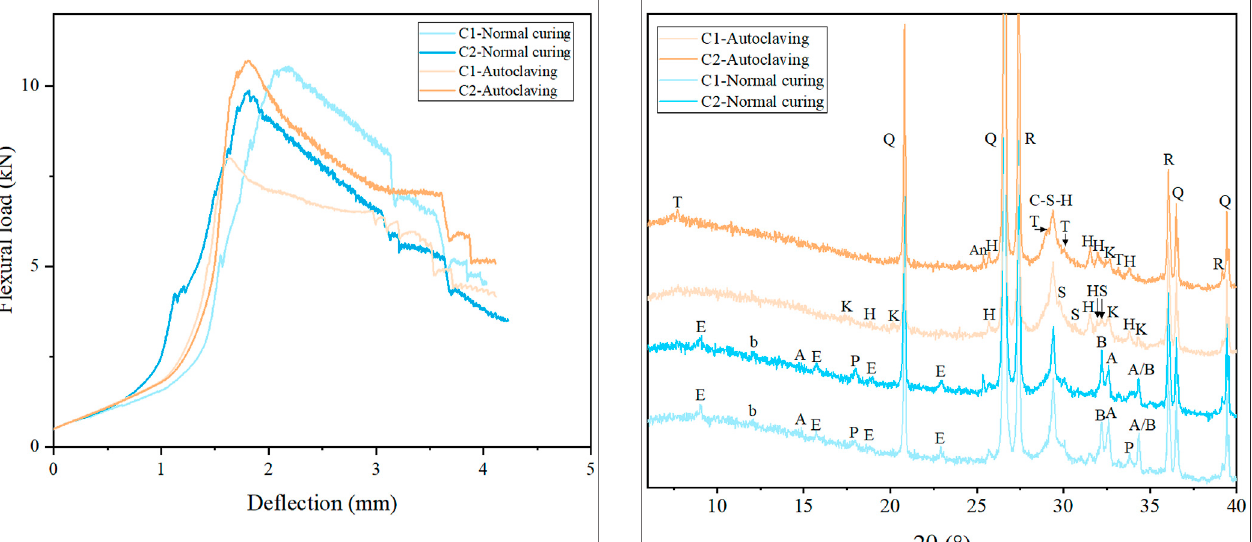
FIGURE 2 | Flexural load-de fl ection curves of the samples after different treatments.